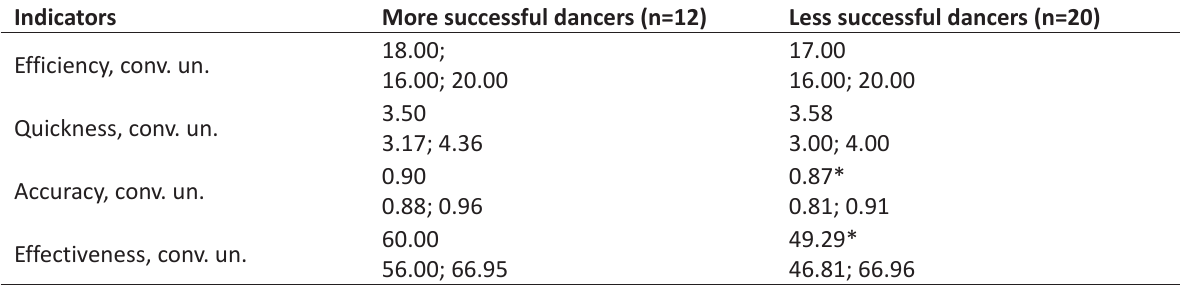
Table 3. Indicators of “comparing numbers” test of dancers with different successfulness (median, top and bottom quartiles) Indicators More successful dancers (n=12) Less successful dancers (n=20) Effectiveness, conv.un. Latency, msec. Accuracy, conv.un. Stability,